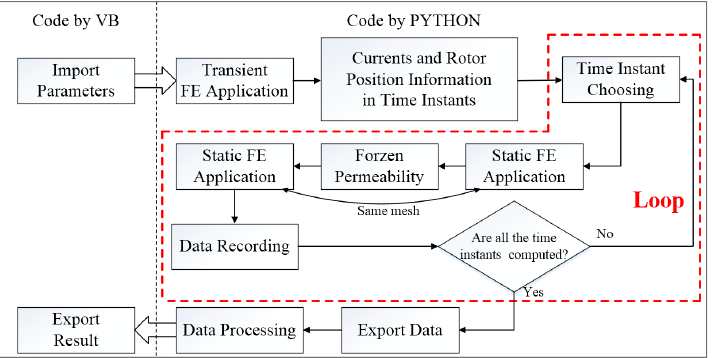
Figure 9. Structure of the developed calculation program.